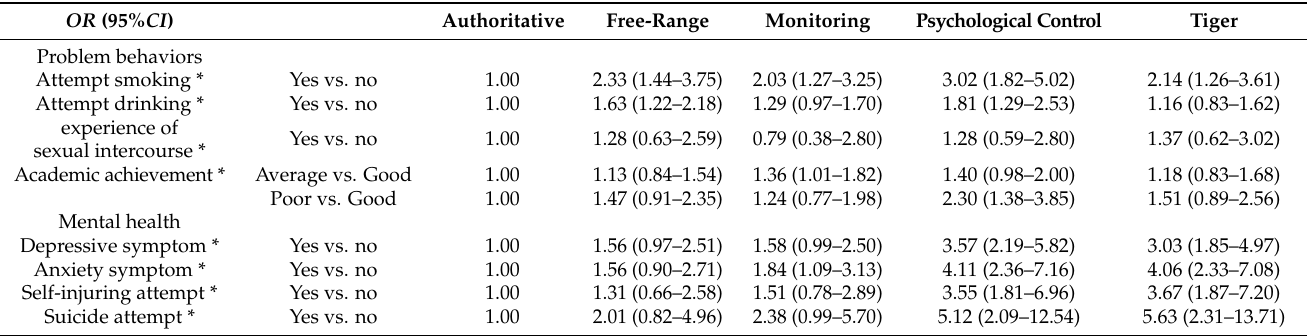
Table 3. Logistic regression on the associations between parenting substyles and adolescents’ out- comes [ OR (95% CI )].